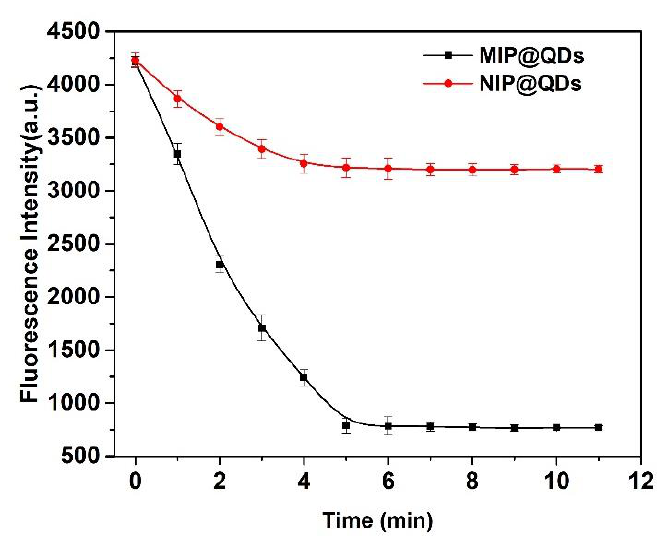
Figure 5. Response time of MIP@QDs and NIP@QDs.